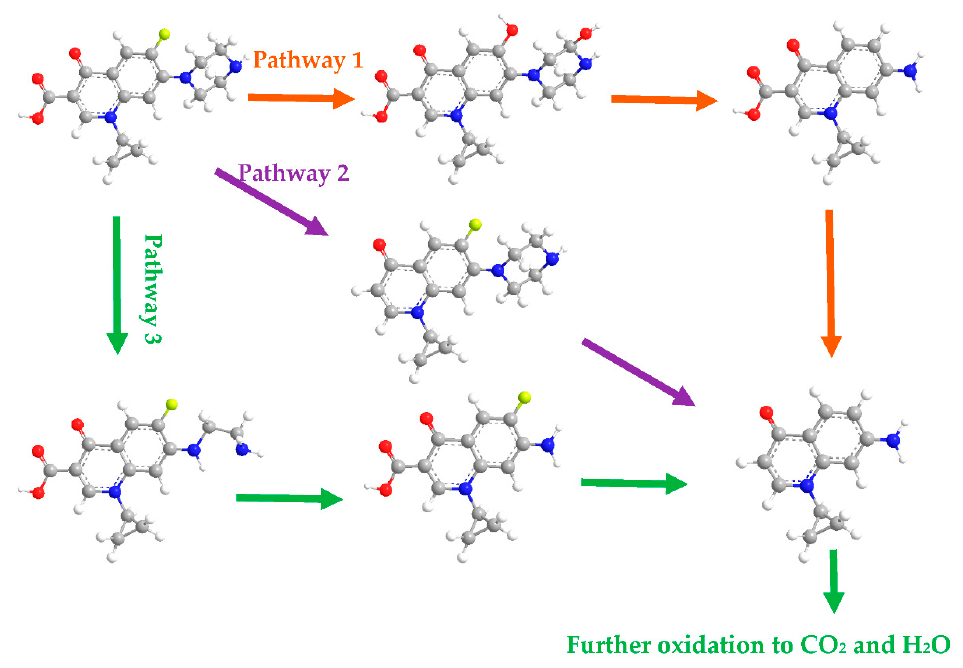
Figure 10. Suggested pathways for ciprofloxacin degradation in CN/La-N-TiO 2 .